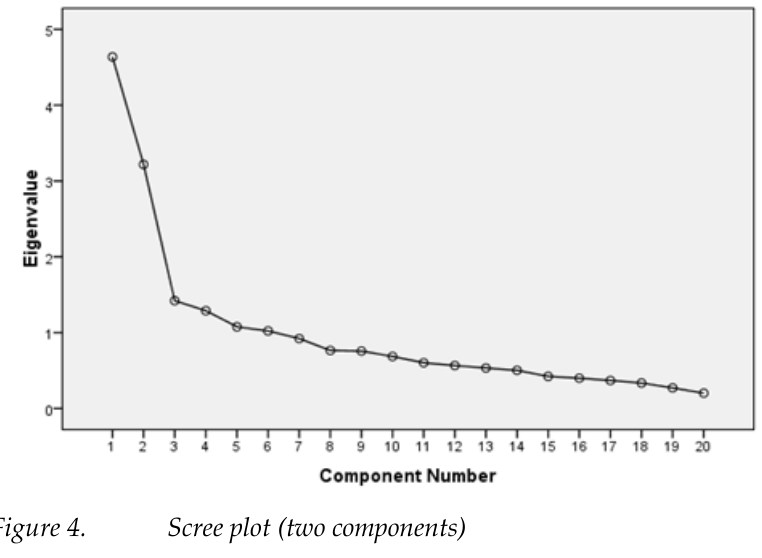
Figure 4. Scree plot (two